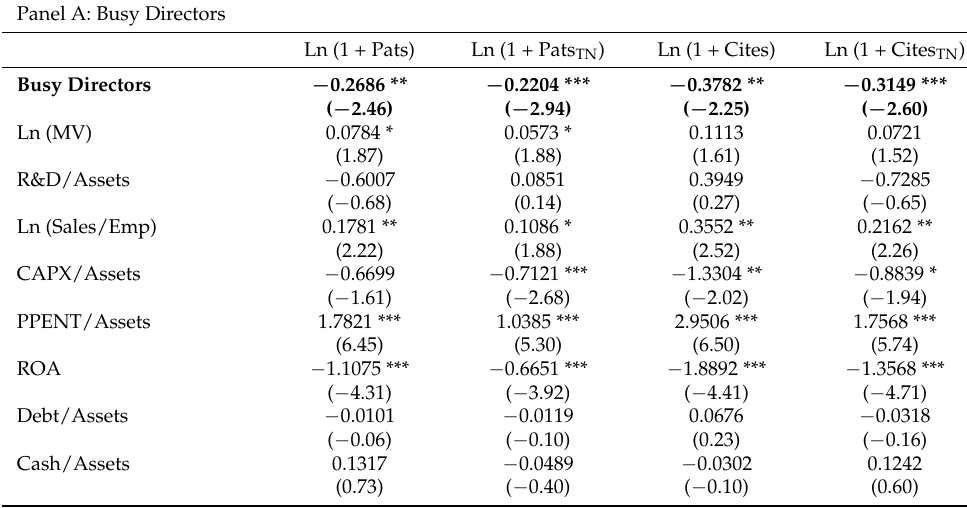
Table 3. Regressions of Innovation on Director Busyness. This table presents regression results of Innovation on various measures of Director Busyness. Panel A examines Busy Directors, defined as the percentage of directors who are on three or more other boards (not including the sample firm); Panel B examines Busy Outside Directors, defined as the percentage of independent directors who are on three or more other boards; Panel C examines Busy Insider Directors, defined as the percentage of employee directors who are on three or more other boards, and Panel D examines Ln (# of Other Boards), defined as the natural logarithm of the average number of other boards that directors serve on. Control variables are omitted for brevity in Panels B, C and D. All regressions contain firm and year fixed effects. All except binary variables are winsorized at the upper and lower 1% levels. Full variable definitions are provided in the Appendix A. T-statistics are reported in parentheses. Standard errors are adjusted based on the Huber–White sandwich estimate of variances and are clustered by firm. *** indicates significance at the 1% level, ** 5% and *